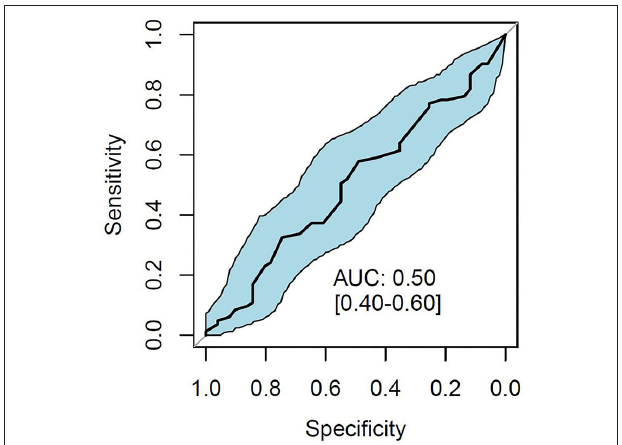
FIGURE 3 | Discriminative capacity of the baseline RALE score for 90-day mortality. AUC, area under the curve; RALE, radiographic assessment for lung